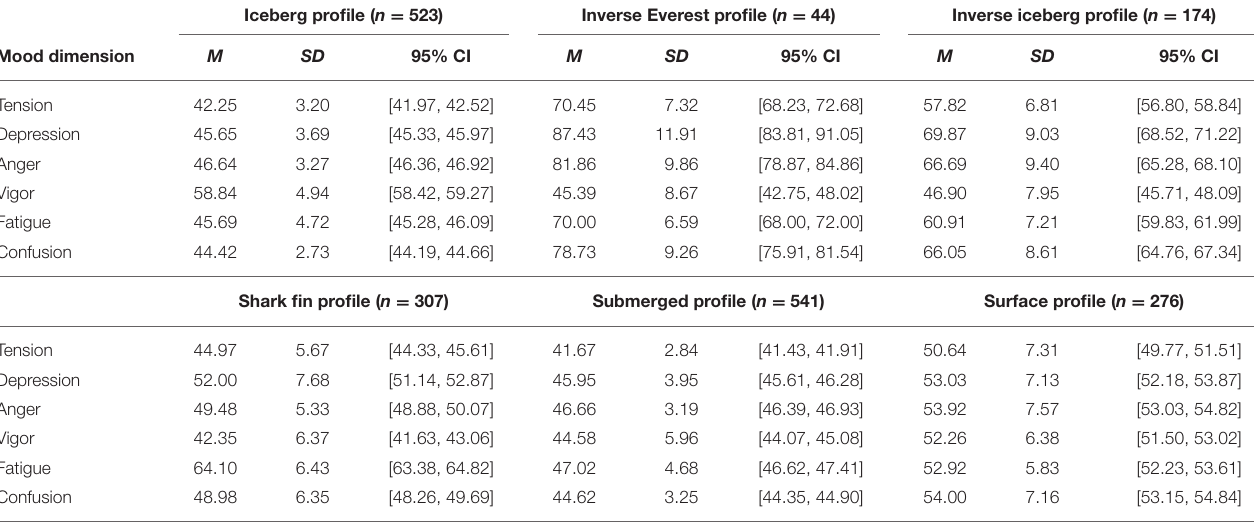
TABLE 10 | Descriptive statistics of the 6-cluster solution in Sample C ( n = 1,865). Iceberg profile ( n = 523) Inverse Everest profile ( n = 44) Inverse iceberg profile ( n =